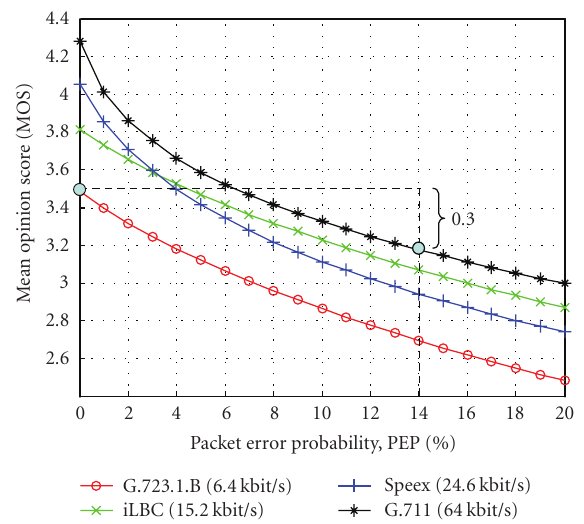
Figure 2: PESQ-based MOS versus packet error probabilities for di ff erent voice codecs.